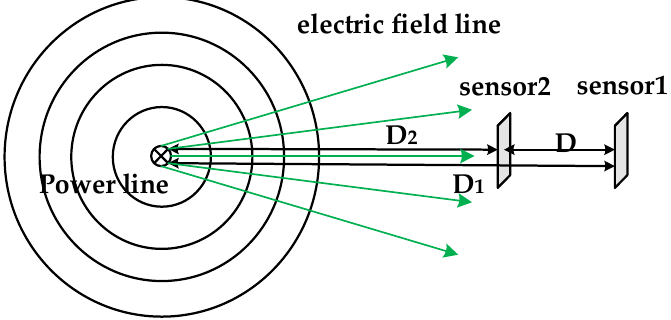
Figure 3. Schematic diagram of the location of the two sensors and the transmission line.